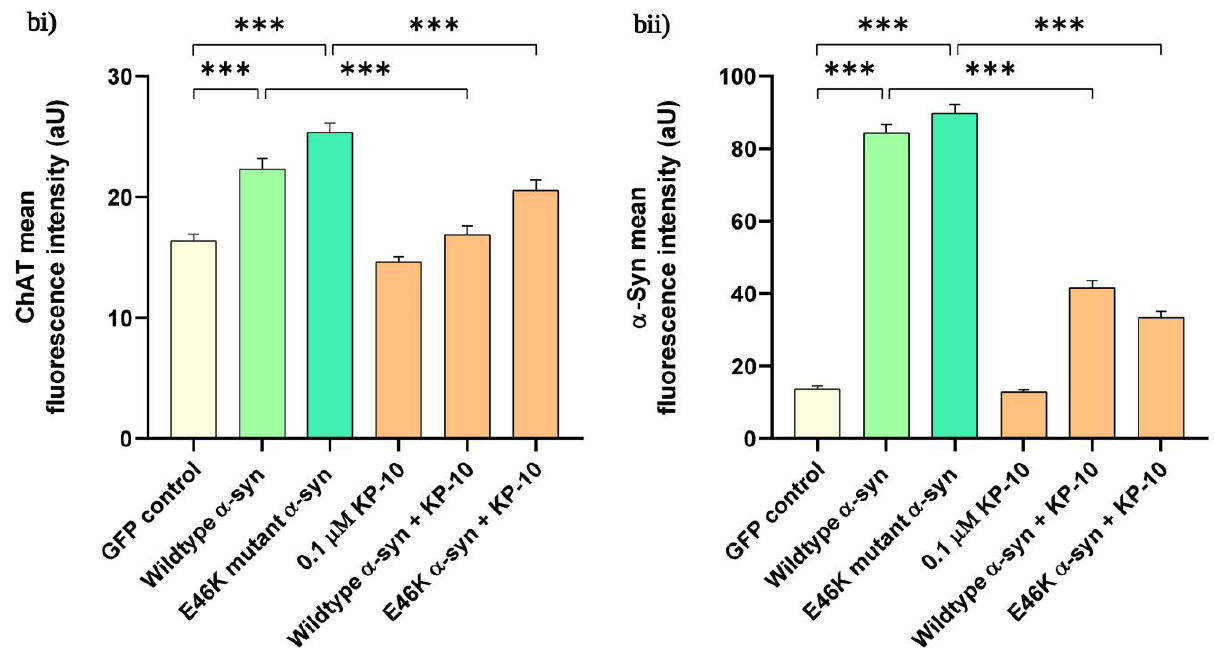
Figure 3. The effect of kisspeptin-10 (KP-10) on α -synuclein ( α -syn) and choline acetyltransferase (ChAT) immunoreactivity in neurons overexpressing human wild-type or E46K mutant α -syn. ( a ) Differentiated neurons overexpressing human wild-type or E46K mutant α -syn were double- immunostained with anti- α -syn (green) and anti-ChAT (red) antibodies, co-stained with Dapi (blue), and representative images were subsequently taken before and after treatment with KP-10. Scale bars, 50 µ m. In this context, 60 neurons were analyzed per experiment. The staining intensity and quantification of α -syn and ChAT expression levels presented in ( b ) are representative of mean values ± SEM from three independent biological experiments. Quantitative analysis of α -syn and ChAT immunoreactions revealed significant increases of fluorescence intensity in both human wild- type (*** p < 0.001) and E46K mutant α -syn (*** p < 0.001) expressing neurons compared with the GFP-labeled neurons. This α -syn-induced upsurge in immunostaining intensity was considerably diminished by the neuroprotective effects of KP-10 (*** p < 0.001). Statistical significance was defined as p -value less than 0.001 (*** p < 0.001).